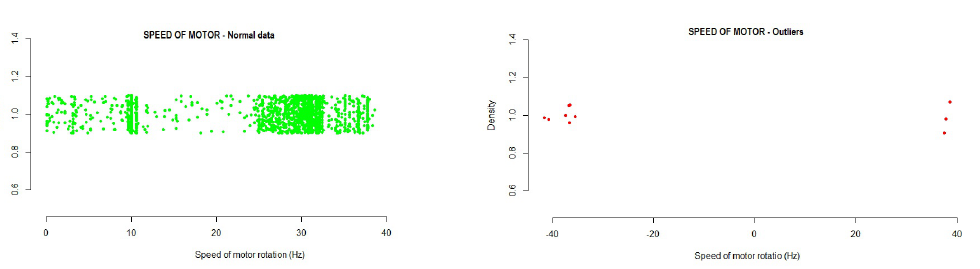
Figure 8. Example of the instantaneous speed of motor rotation outliers detected in the testing